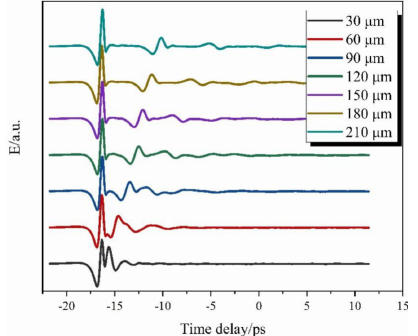
Figure 5. Terahertz signals of TBCs with different TC